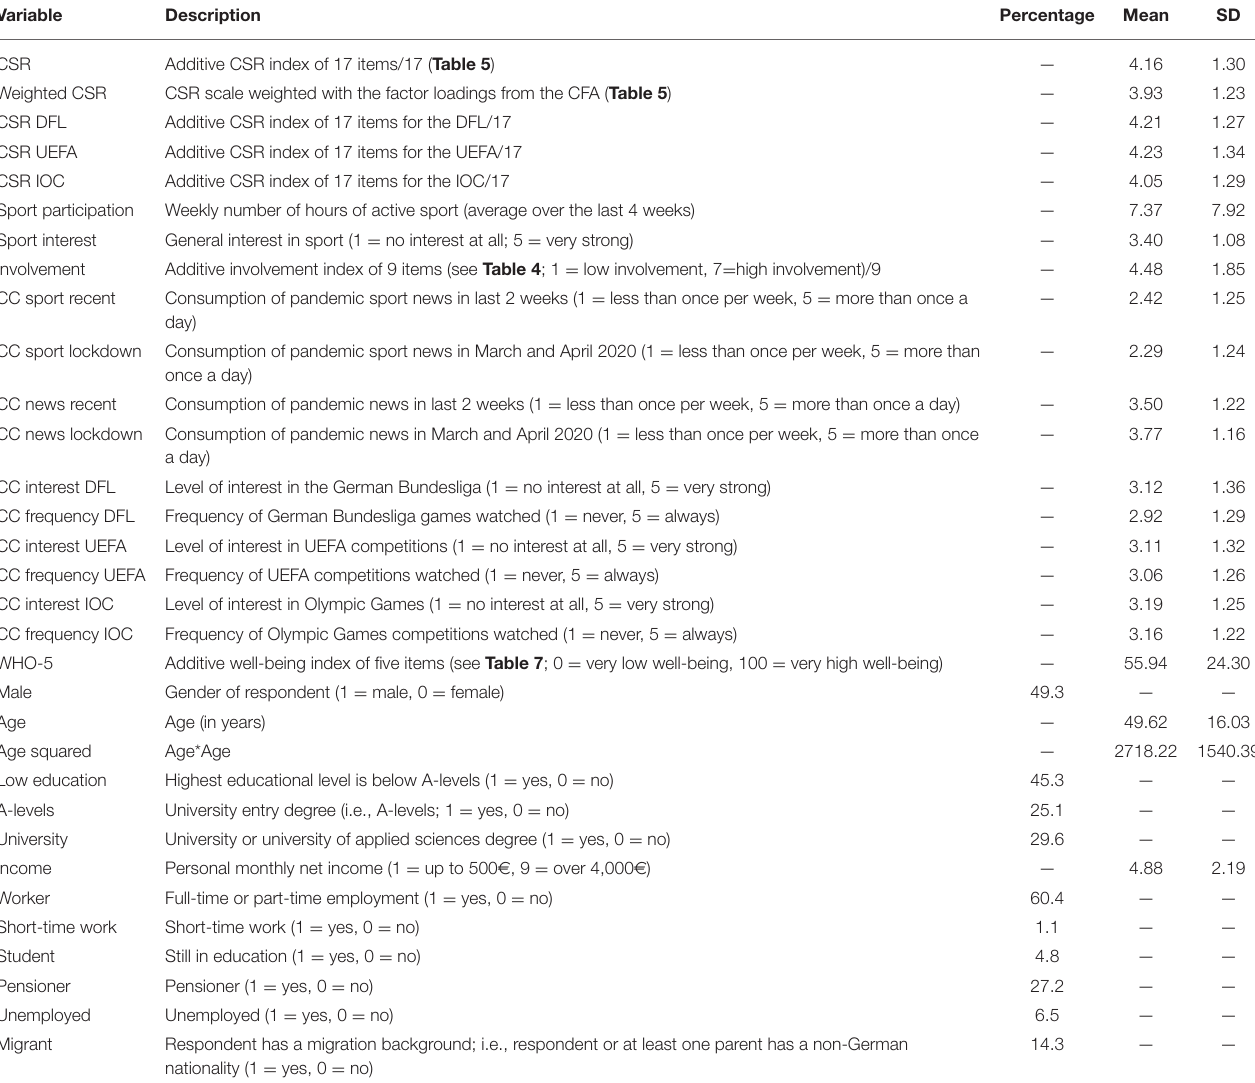
TABLE 3 | Overview of variables and summary statistics ( N =